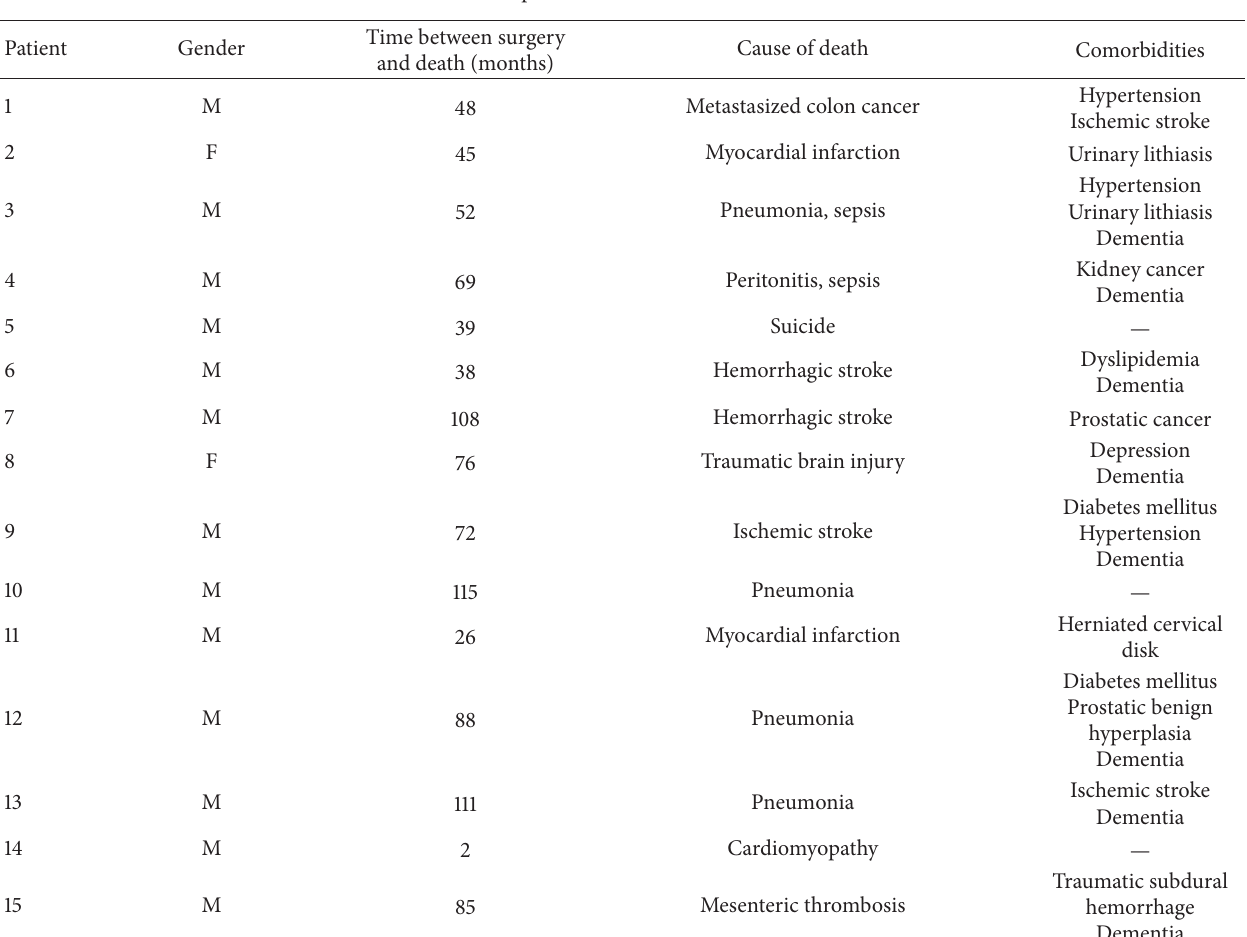
Table 2: Deceased PD patients treated with DBS. M: male, F: